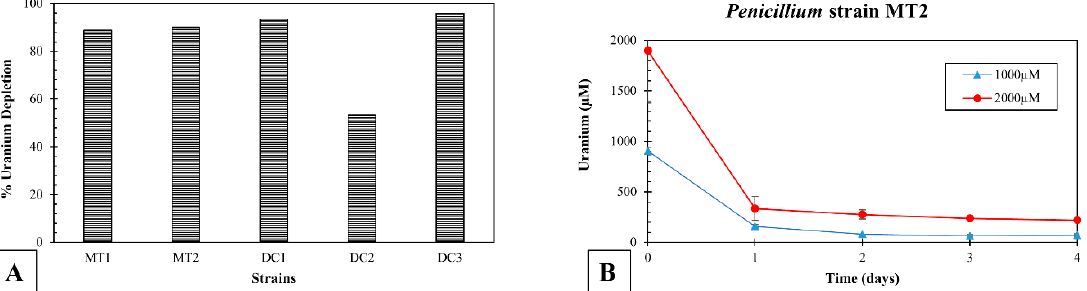
Figure 6. Soil microcosms established with uranium (U) (1000 µ M and 2000 µ M) and the bacterial / fungal isolates obtained from DC and MT chambers. Shown is the percent depletion of soluble U at the experiment cessation time point for all strains, at 2000 µ M ( A ), and U depletion over a 4-day period by strain MT2 ( B ), respectively.